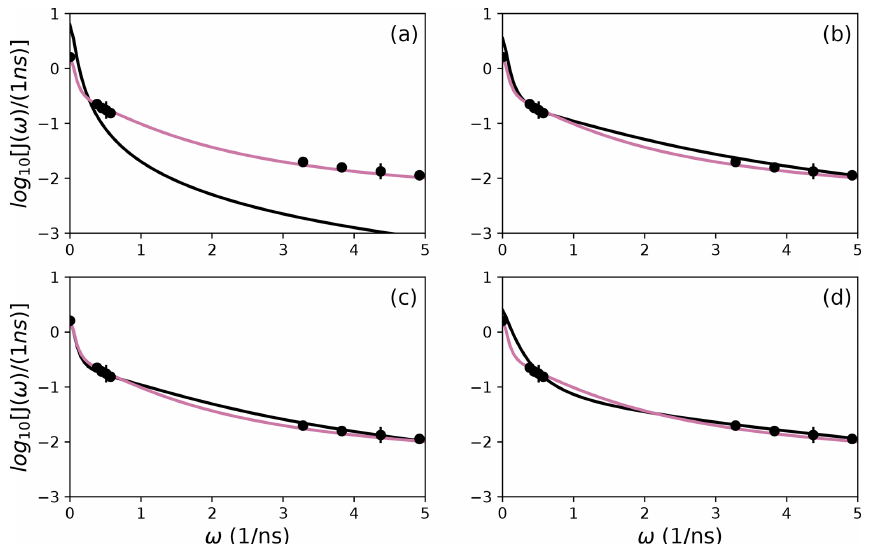
Figure 9. Comparison of individual fits for Arg 11 of (a) Model 1, (b) Model 3, (c) Model 4, and (d) Model 5 (black lines) or the bootstrap aggregation smoothed fit (reddish-purple line) to (circles) experimental spectral density values.